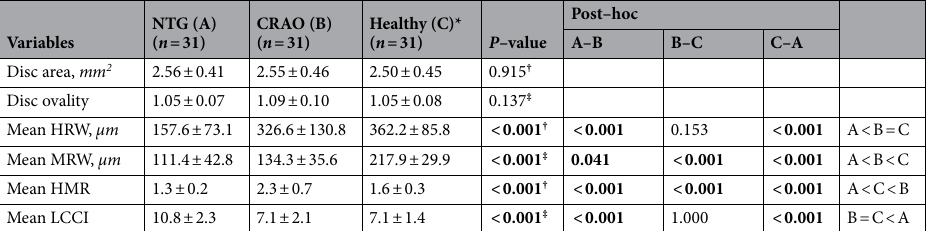
Table 2. Comparison of optic nerve head morphology between the groups ( n = 93). Values are shown in mean ± standard deviation, with statistically significant P –values in boldface. NTG normal tension glaucoma, CRAO central retinal artery occlusion, HRW horizontal rim width, MRW minimum rim width, HMR horizontal-to-minimum rim width ratio, LCCI lamina cribrosa curvature index. *Healthy fellow eyes of CRAO subjects. Comparison was performed using Kruskal–Wallis † and ANOVA ‡ .